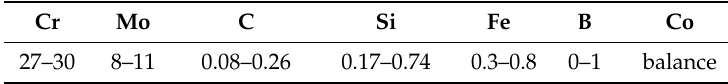
Table 1. Chemical composition of the studied alloys (wt %).